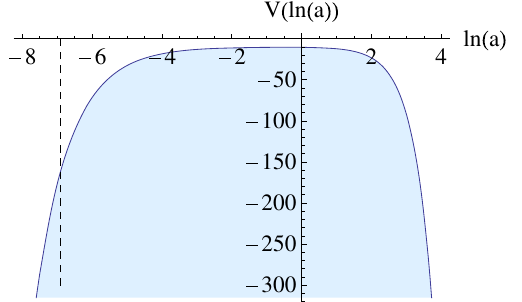
Fig. 1 The diagram presents the evolution of scale factor a for a flat universe for α parameter equal 1.82. Note that, for a = 10 − 3 , it appears the generalised sudden singularity